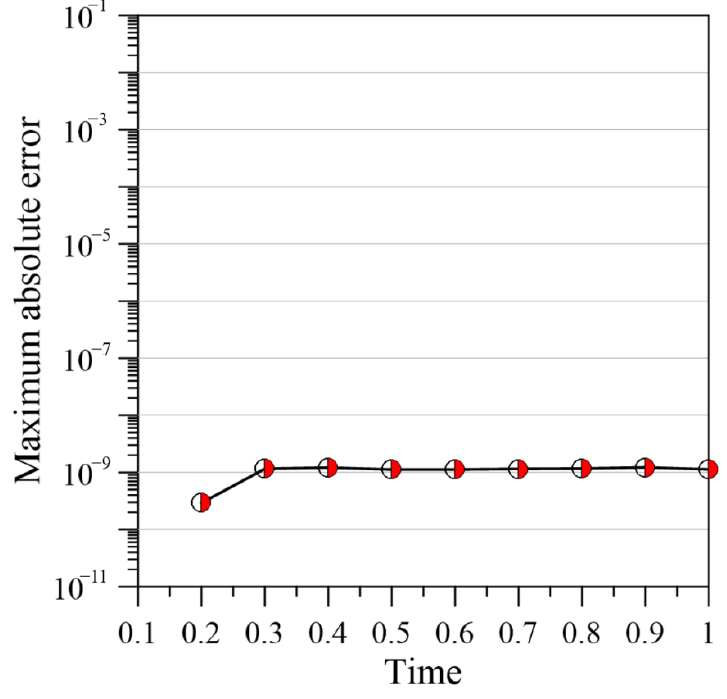
Figure 9. MAE versus simulation time.